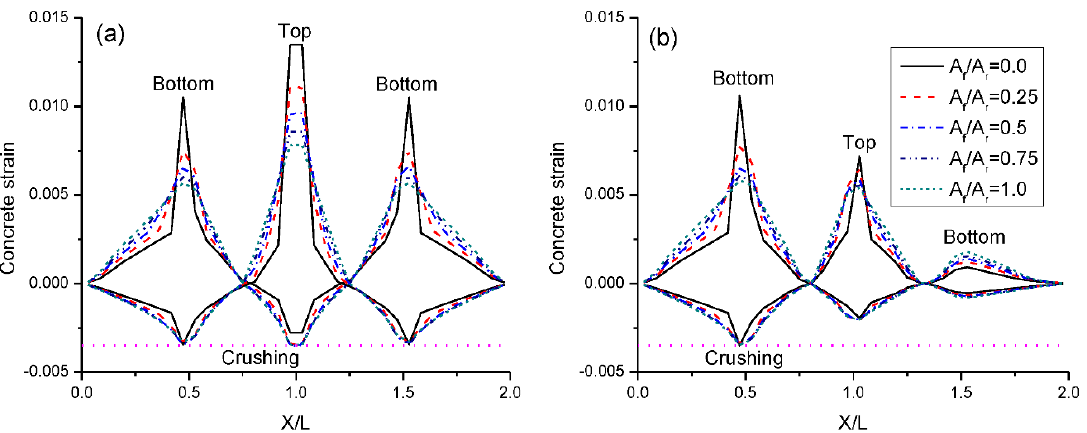
Figure 3. Concrete strain distribution: ( a ) symmetrical loading; ( b ) unsymmetrical loading. ( X / L = ratio of distance from end support to span).